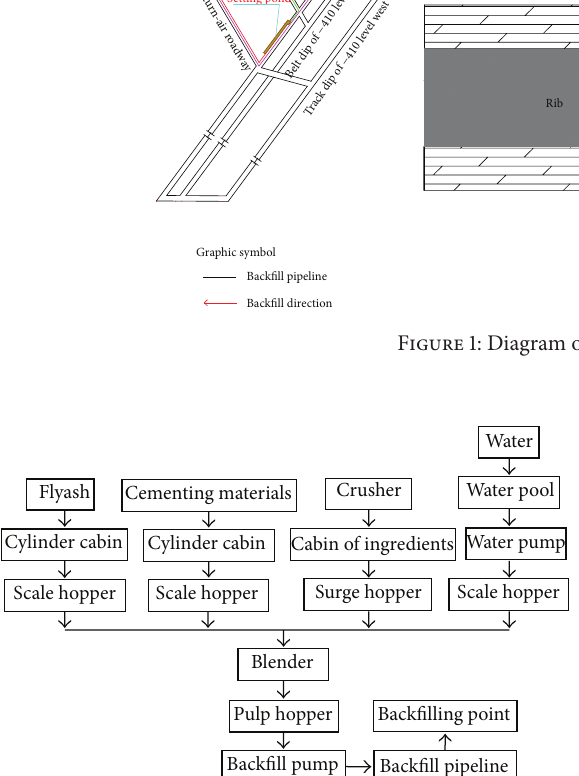
coal mines. Therefore, it is beneficial for protecting